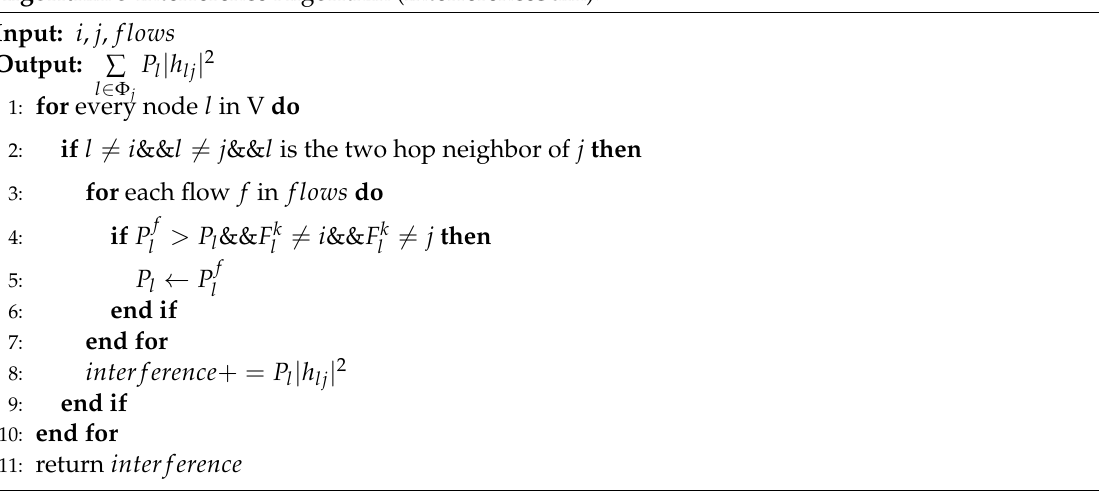
Algorithm 3 Interference Algorithm (InterferenceSum).